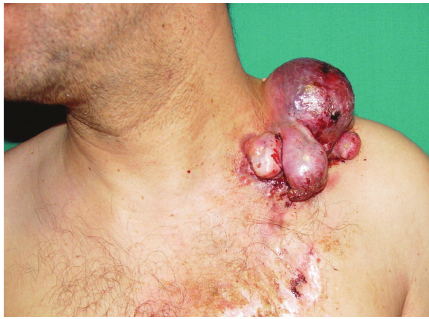
Figure 1: Preoperative image of the mass.